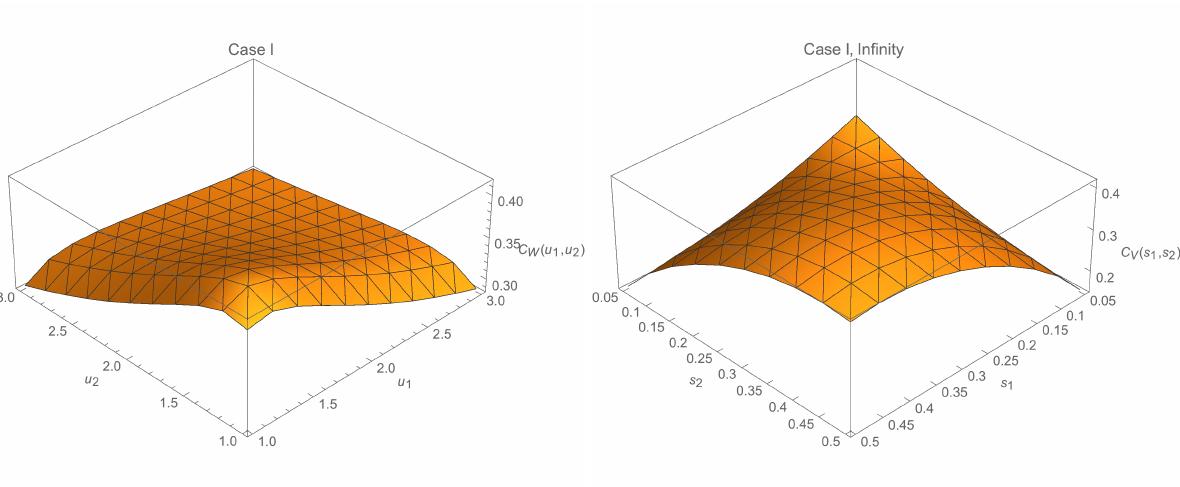
Fig. 3 Covariance function given by (3) in the Case I to both problems, IVP (4) (left) and IVP (17) (right) for the values of u 1 , u 2 ∈ [ 1 , 3 ] and s 1 , s 2 ∈ [ 0 . 05 , 0 . 5 ]